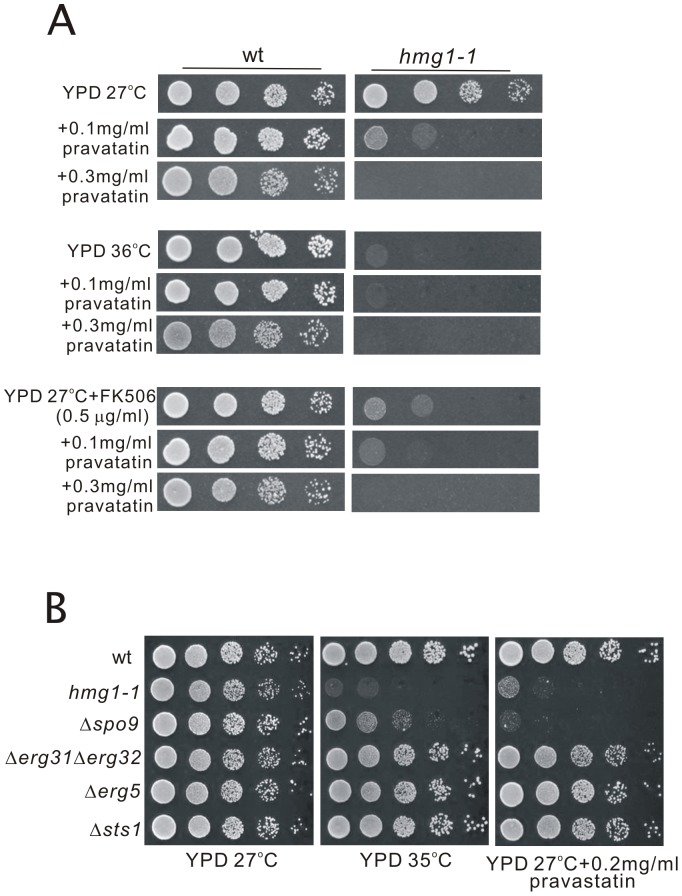
Application of pravastatin to wild-type cells does not cause the similar defects to the phenotypes of hmg1-1 mutant, and both of the hmg1-1 mutant and Δspo9 cells exhibited overlapping phenotypes.(A) Effect of pravastatin and FK506 on the growth of wild-type cells. Wild-type cells and hmg1-1 mutants were spotted onto YPD plates or YPD plus pravastatin or/and FK506 as indicated, and then incubated for 4 days at 27°C or at 36°C. (B) Genetic interaction between hmg1+ and spo9+ genes. Wild-type, hmg1-1, Δspo9, Δerg31Δerg32, Δerg5, and Δsts1 cells were spotted onto each plate as indicated and then incubated for 4 days at 27°C or at 35°C.